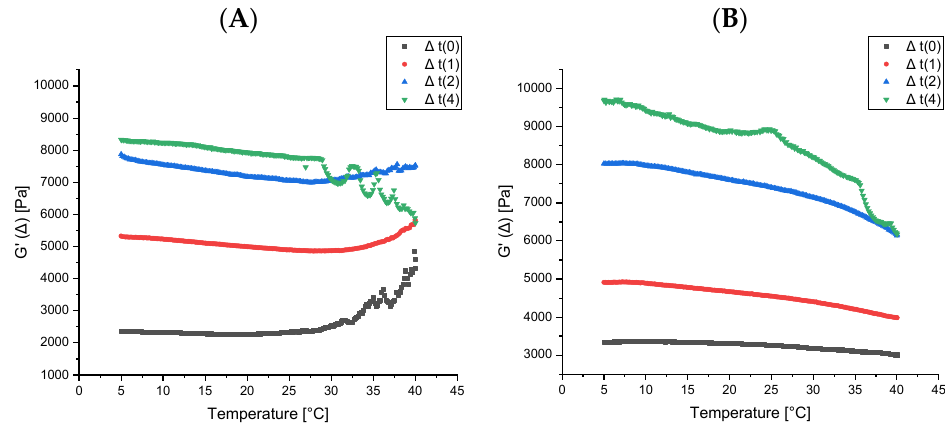
Figure 8. Time Cure test for the PCGT ( A ) and PPLOMW ( B ) food matrix over time (weeks).